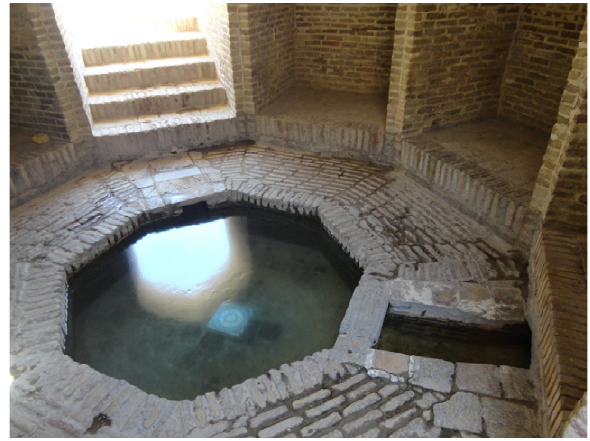
Figure 1. Quanat in Meibod, Iran